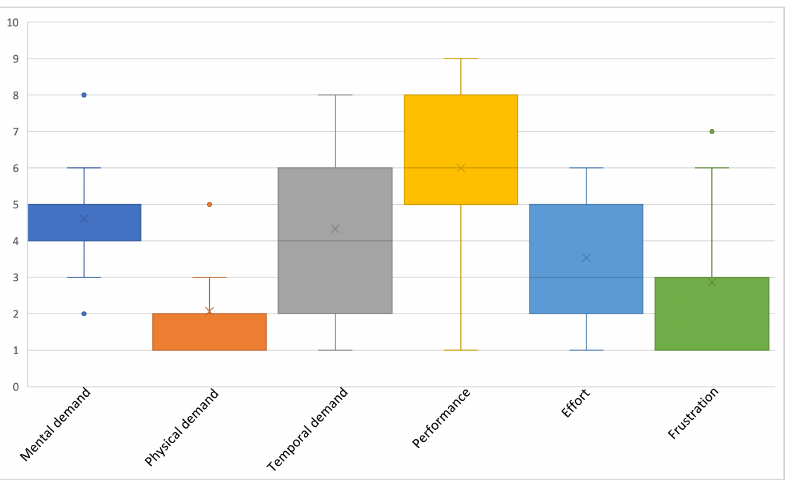
Figure 17. A boxplot of the NASA-TLX result for the analysis of plant growth use case. Each of the six subscales was captured with a 10-point continuous scale from very low (1) to very high (10) . The X-axis indicates the sub-dimensions of the score. The Y-axis indicates the statistics for each